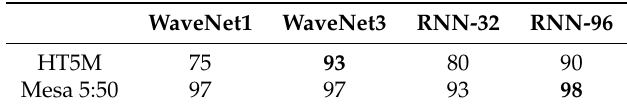
Table 3. Mean MUSHRA